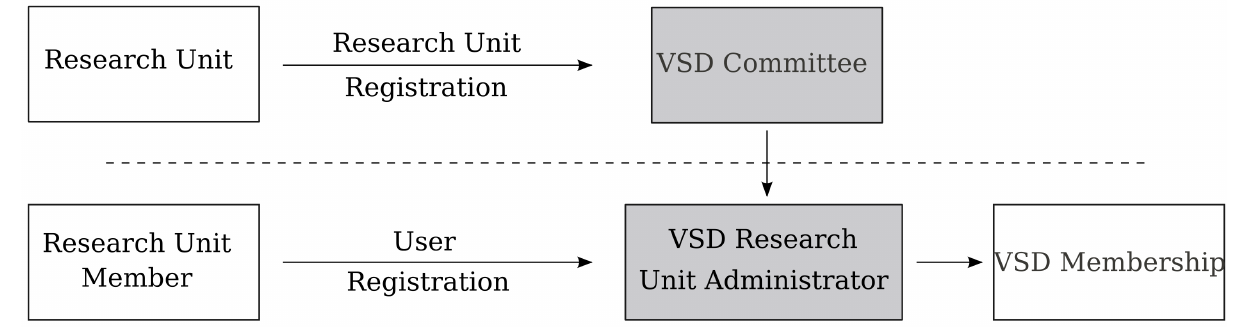
Figure 2. Registration process - Top: registration of a new research unit and appointment of a research unit administrator. Bottom: individual users can register to a research unit and have to be accepted by the respective administrator.